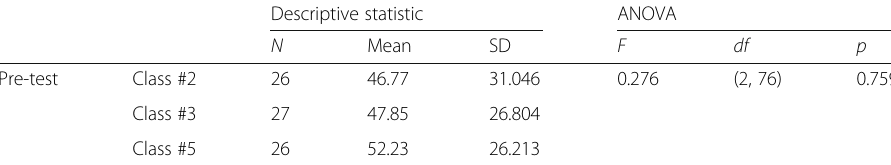
Table 14 Independent t test result for students ’ academic achievements in different groups